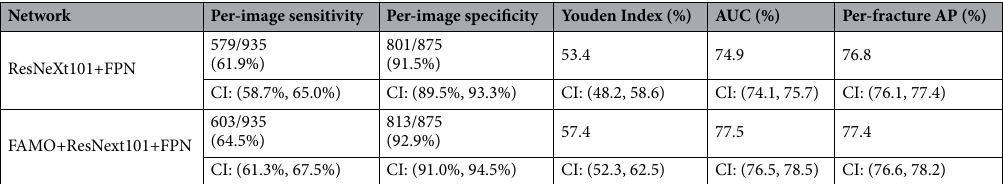
Table 1. Improvement of FAMO in per-image and per-fracture level. Note: ResNeXt101, a network structure; FPN, feature pyramid network; FAMO, Feature Ambiguity Mitigate Operator (FAMO) method; AUC, area under the curve; AP, average precision; CI, confidence interval. All CIs were calculated at the two-tailed significance of 0.05.